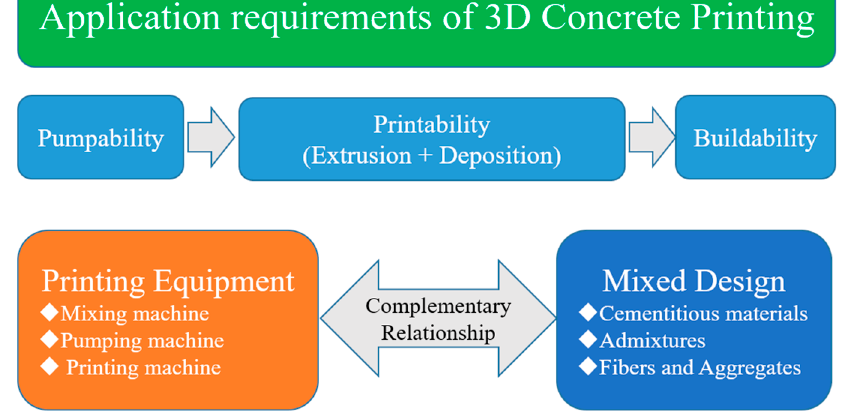
Figure 1. The performance of 3DCP during the printing process.